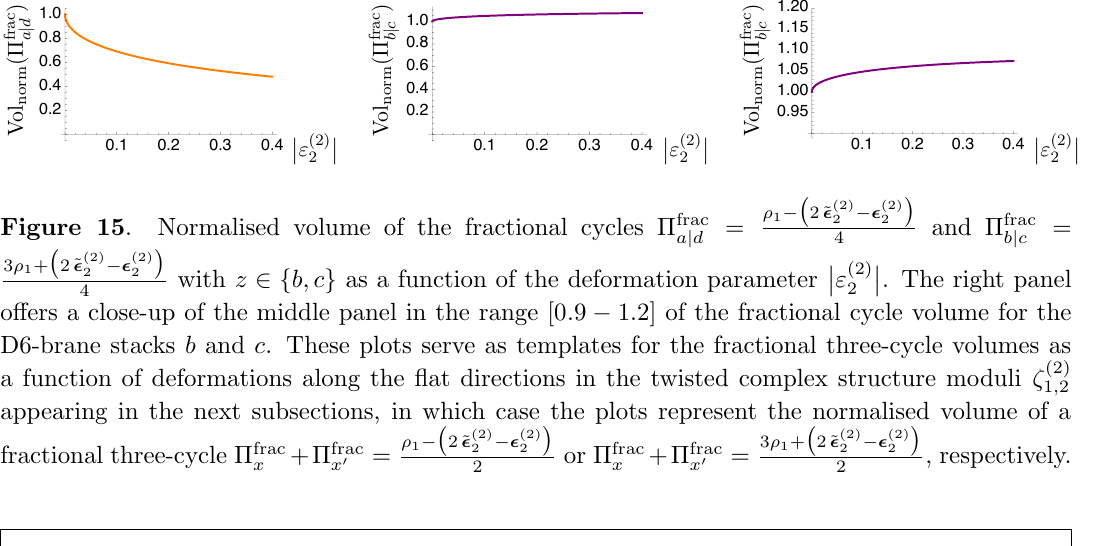
D6-brane con(cid:12)guration of a global 5-stack MSSM model on the aAA lattice wrapping numbers